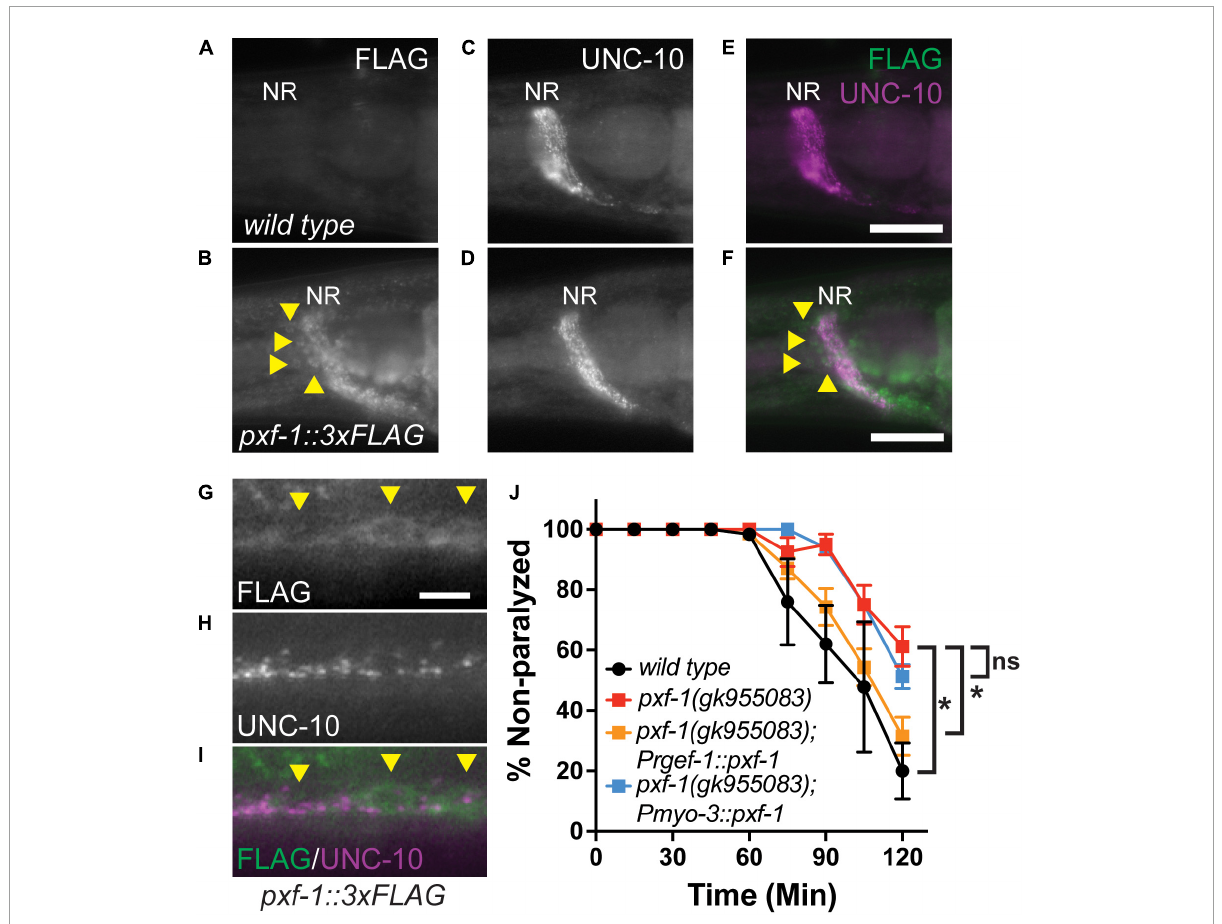
FIGURE2 PXF-1 is expressed and functions in neurons. (A,B) FLAG staining, (C,D) UNC-10 staining, and (E,F) merged channels of heads of adult wild type and pxf-1:3xFLAG animals. NR indicates nerve ring. Arrowheads indicate neuron cell bodies. Scale bars are 25 µ m. (G) FLAG staining, (H) UNC-10 staining, and (I) merged channels of ventral cord of pxf-1:3xFLAG adult animals. Arrowheads indicate motor neuron cell bodies. Scale bars are 5 µ m. (J) Quantification of non-paralyzed animals during 120 min of exposure to 1 mM aldicarb. Transgenic PXF-1 cDNA was expressed using neuronal rgef-1 and muscle myo- 3 promoters. Dots represent means, and error bars indicate SEM. n = 6–8 trials. * p < 0.05; ns, not significant at 120 min.